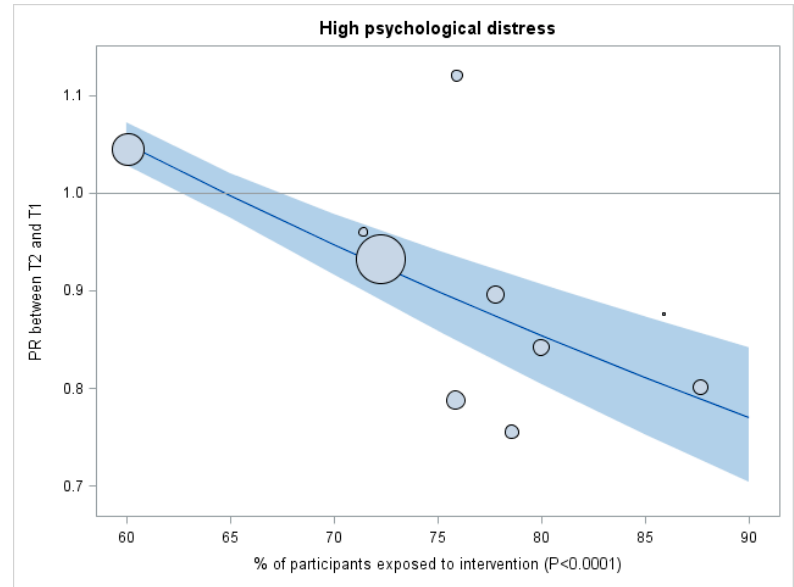
Figure 2. Proportion (%) of participants exposed to interventions in the Management Practices area of the QHES 1 as a continuous variable: Prevalence ratios (PR)